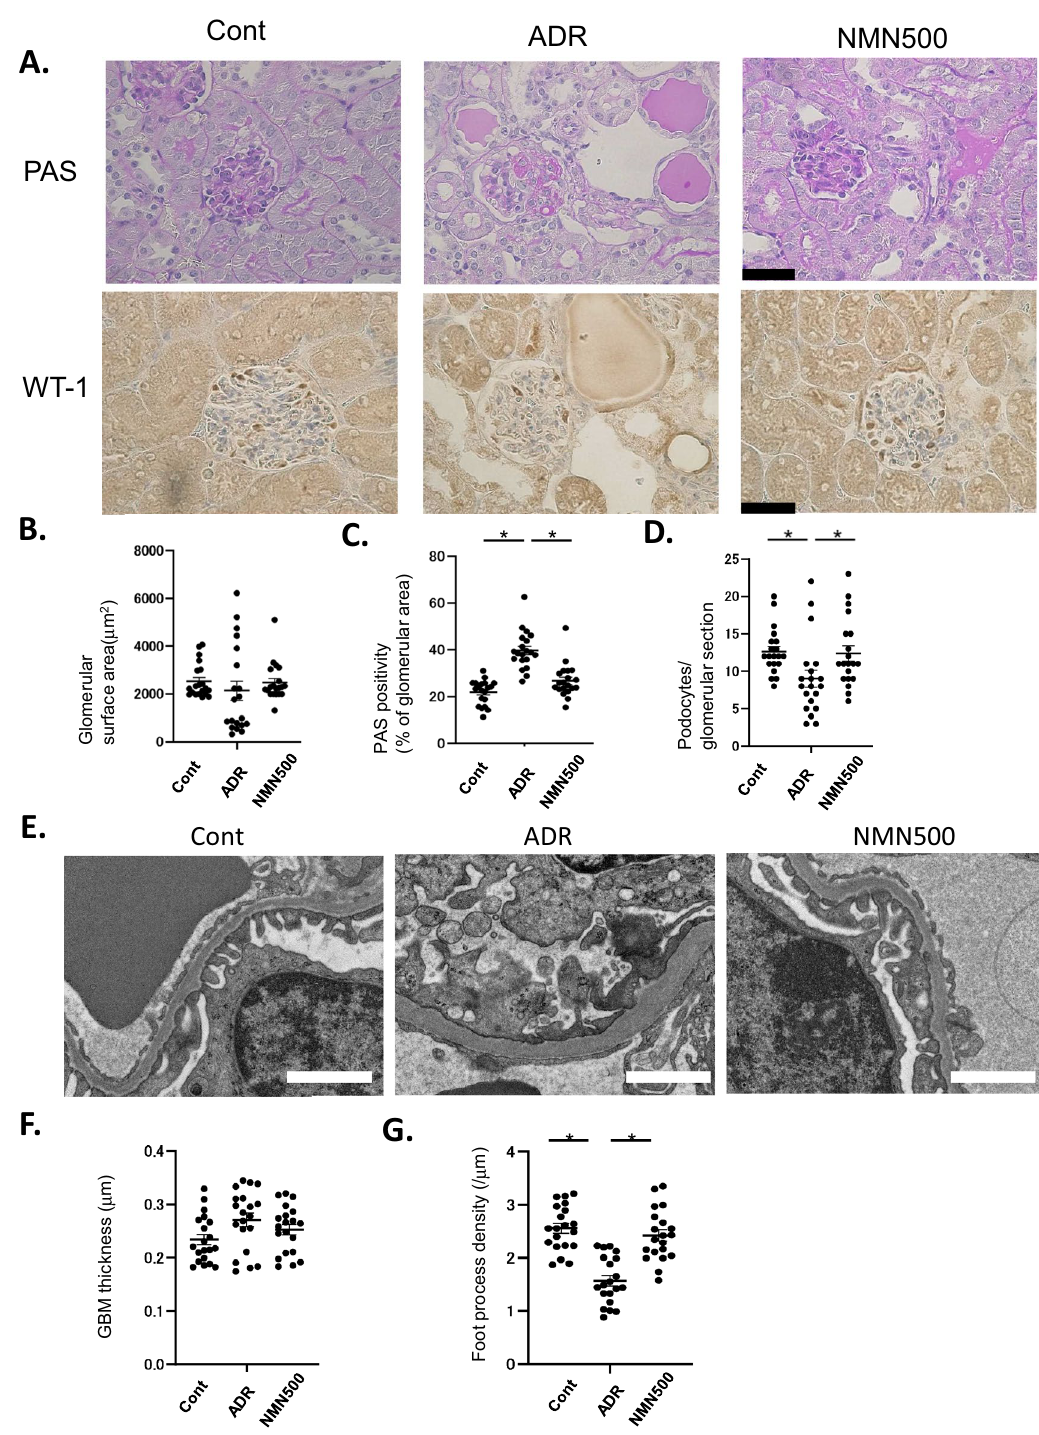
Figure 4. Short-term NMN treatment ameliorated the histological changes in FSGS. ( A ) Representative images of PAS and WT1 immunostaining in the glomeruli of the mice from the Cont, ADR, and NMN500 groups (scale bar 500 µm). ( B ) Graph showing the glomerular surface area. ( C ) Graph showing the PAS positivity in the glomerular area within the PAS-stained kidney sections; n = 20 sections per group. ( D ) Graph showing the number of podocytes per glomerulus detected using the antibodies to WT1. ( E ) Representative EM images of GBM in the Cont , ADR , and NMN500 groups. The GBM and foot processes are indicated (scale bar 1 µm). ( F ) Graph showing the GBM thickness obtained from 20 measurements per group. ( G ) Graph showing the density of the foot process per micron of GBM obtained from approximately 20 measurements per group. All data are shown as mean ± standard error of the mean. Statistical significance between each group is represented by a horizontal bar. * P <